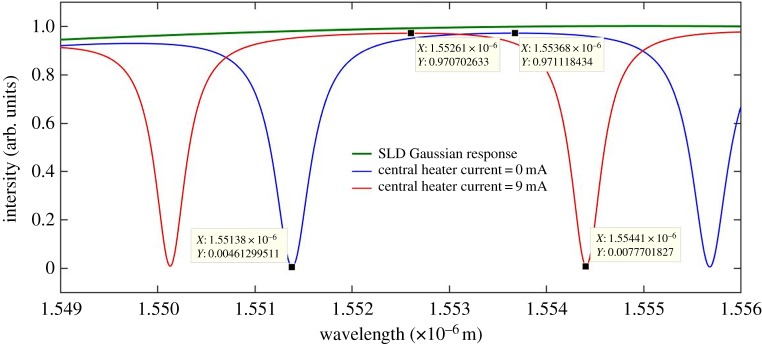
Expanded spectrum of of figure 13.